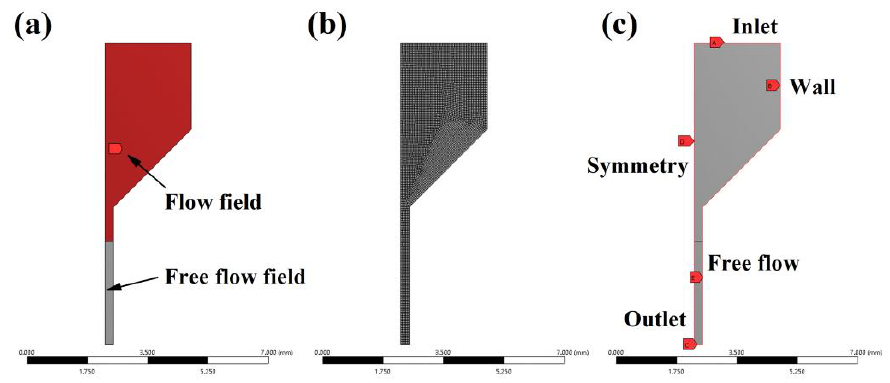
Table 1. Parameters of Herschel – Bulkley model.